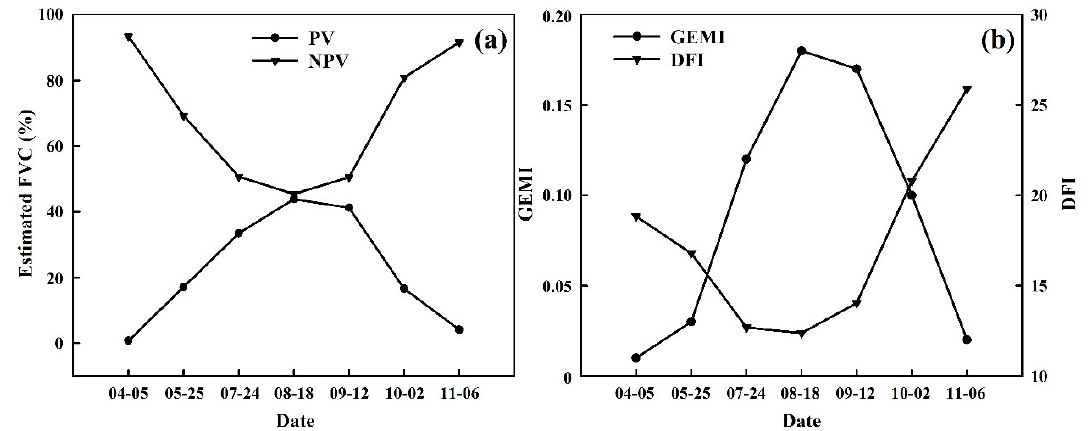
Figure 11. ( a ) Temporal variation of the f PV and f NPV in the area of b. ( b ) Temporal variation of the GEMI and DFI values in the b region.